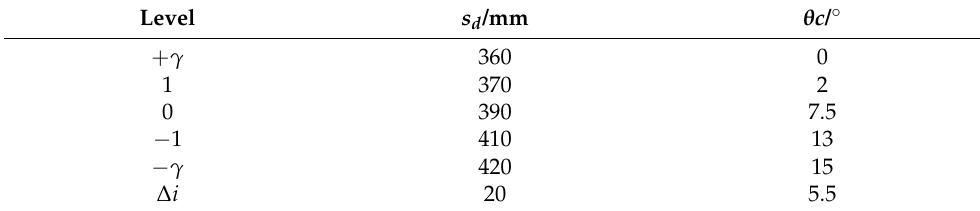
Figure 11. Structure diagram of the test bench. Note: (1) straw conveyor belt; (2) safety box; (3) mo- tor; (4) support stand; (5) SCTD. Table 2. Test factors and levels. Table 2. Test factors and levels.